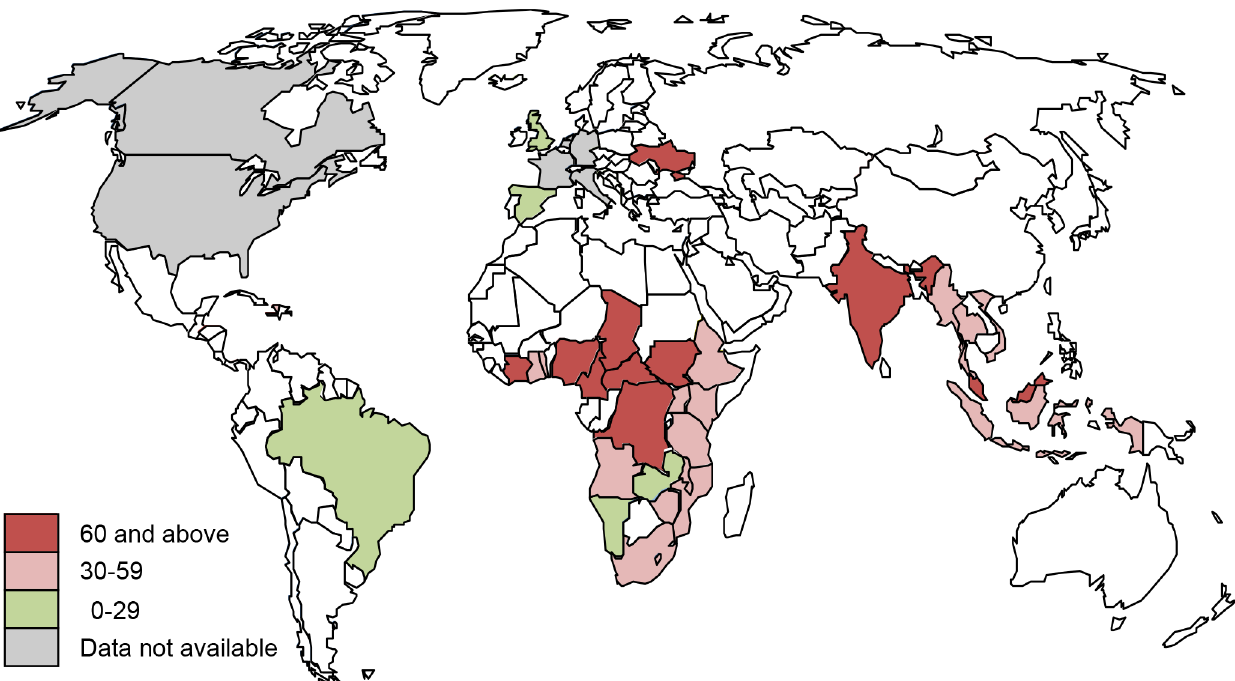
Fig 2. Global AIDS-related death rate per 1000 people living with HIV in 2013. Map of AIDS death rate per 1000 people living with HIV for 2013 for 30 high AIDS mortality burden countries and eight high-income countries. UNAIDS AIDS-related deaths estimates for 2013 are not available for countries shown in grey. Countries in white were not included in